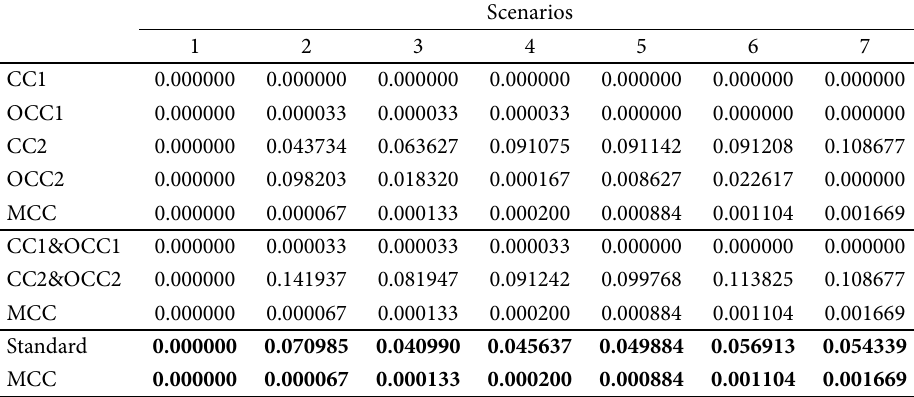
table 16. Overall errors of models for scenarios